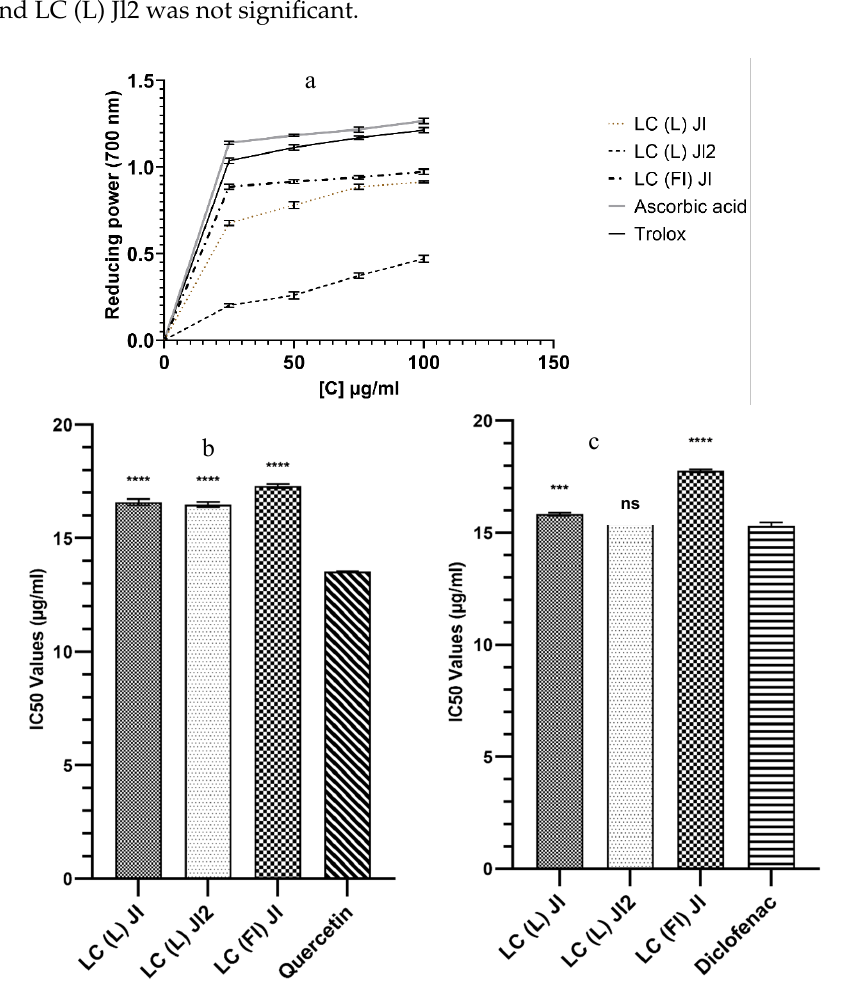
Figure 6. ( a ) Reducing power of L. camara essential oil, Trolox, and Ascorbic acid. ( b ) Anti-inflammatory by LOX inhibitory activity of L. camara essential oil. ( c ) Anti-inflammatory activity by denaturation of bovine albumin of L. camara essential oil. Values are expressed in ± SD (n = 3 experiments), **** p < 0.0001, *** p < 0.001, ns (non-significant), compared to Diclofenac, Quercetin (one-way ANOVA followed by Tukey’s multiple comparisons test).